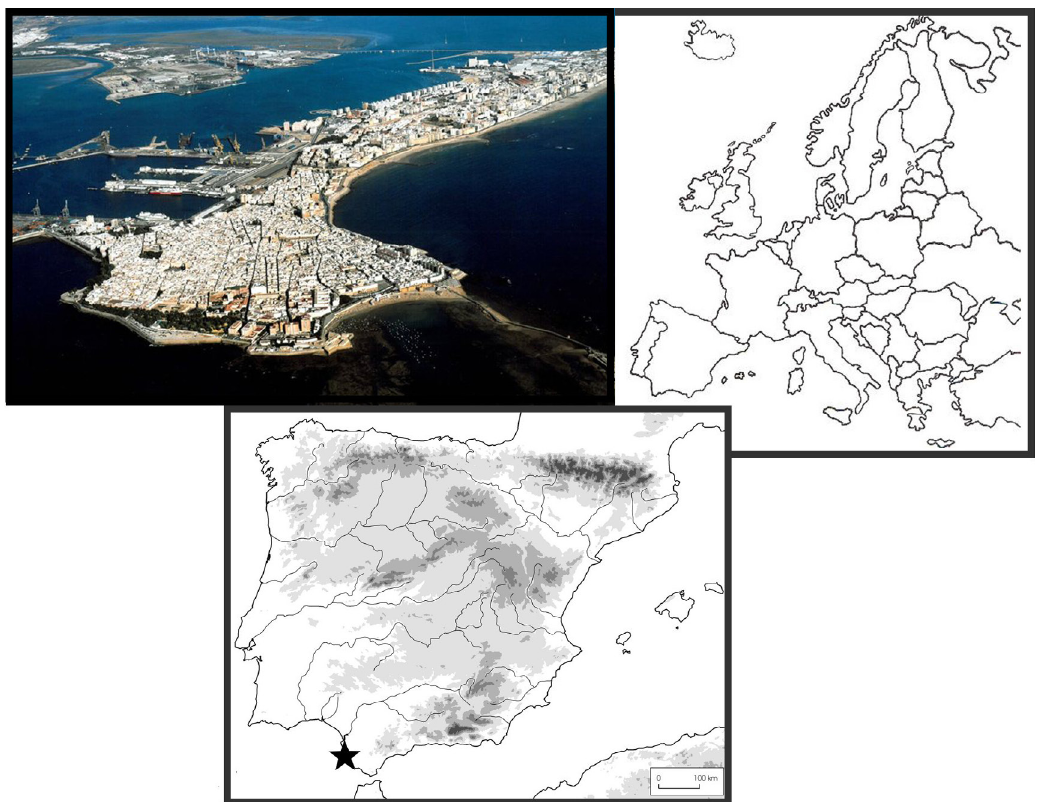
Figure 1. Geographical situation of Cadiz with respect to Europe and the Iberian Peninsula.